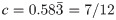
Front propagation in secondary tauopathy; rectangular domain.Each subfigure consists of a toxic Aβ concentration distribution (top left), toxic τP concentration distribution (bottom left) and a plot (solid line: Aβ, dashed line: τP) of the concentration level on the x−axis. Dark blue indicates the minimum concentration of c = 0.0 while bright red indicates the maximum of c = 0.5 for toxic Aβ and c=0.583¯=7/12 for toxic τP. See the Methods section (Front propagation) for a comparison to theory. (See also: supplementary S3 Video).